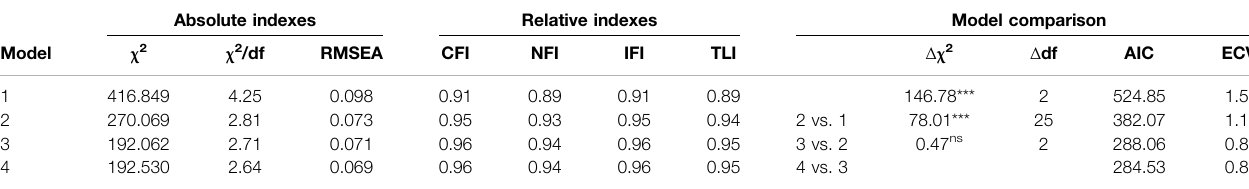
TABLE 3 | Goodness-of- fi t indices and a comparison among the four models. Absolute indexes Relative indexes Model